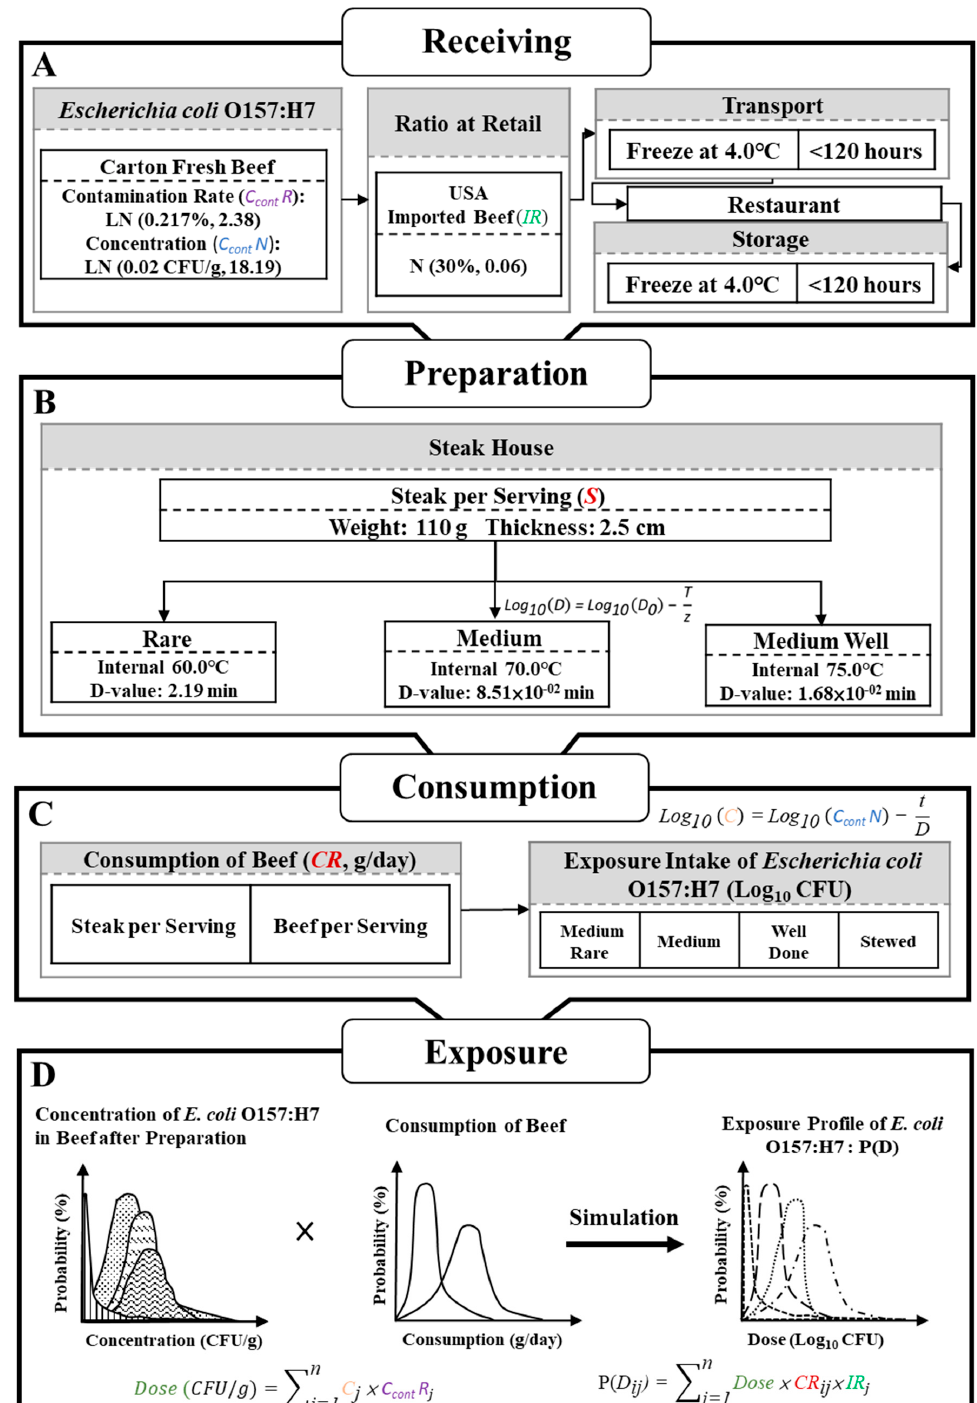
Figure 1. Assumptions for various scenarios of consumption of beef imported from the United States of America to Taiwan when beef is infected by Escherichia coli O157:H7. ( A ) Receiving, transportation, and storage of beef, ( B ) Preparation of beef, ( C ) Consumption of beef, and ( D ) Exposure profile of E. coli O157:H7. Note: LN = log normal distribution; N = normal distribution; D-value = decimal reduction time; CFU = colony forming